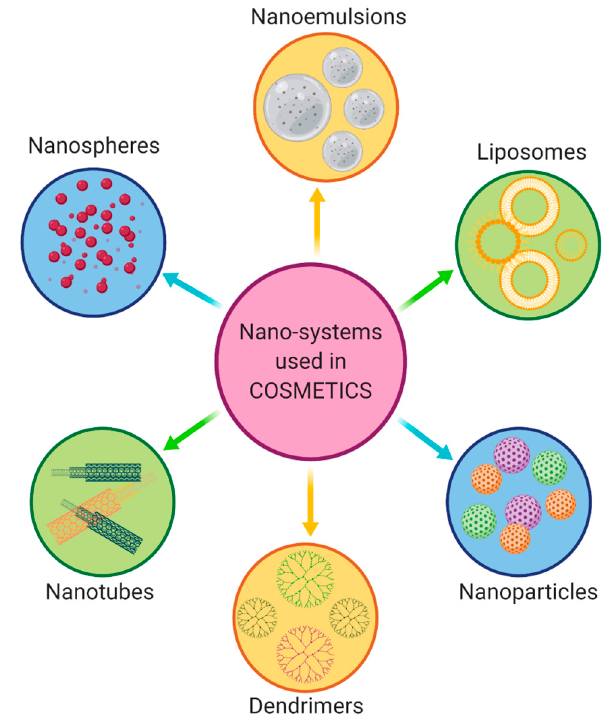
Figure 1. Various nanostructured cues used in cosmetics. The figure was created with the “BioRender.com” template and exported under the terms of premium subscription.